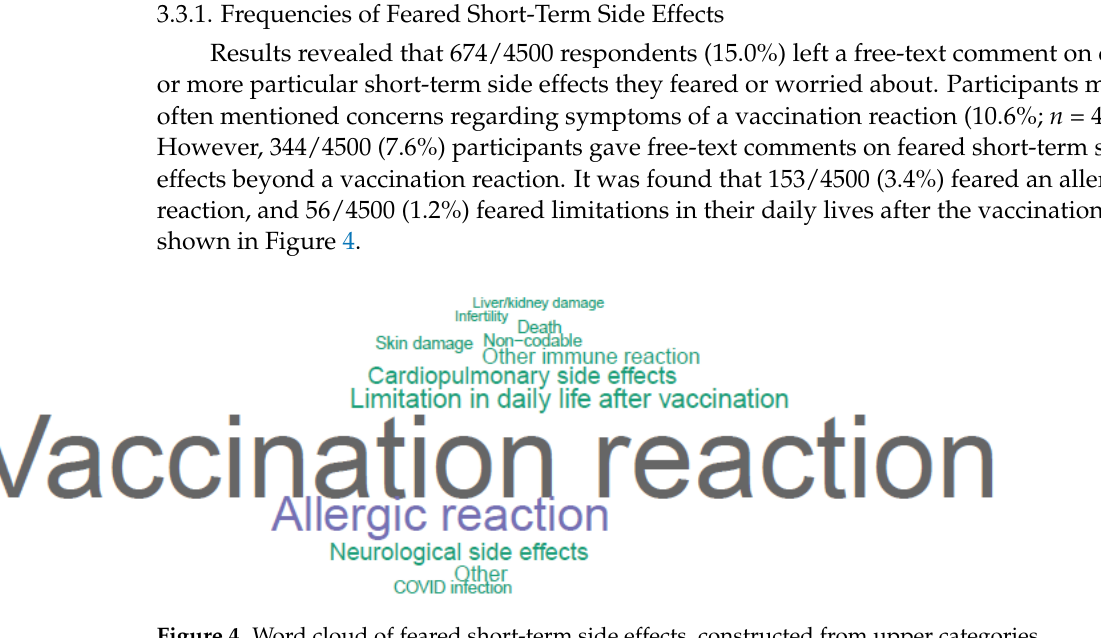
Figure 4. Word cloud of feared short-term side effects, constructed from upper categories.